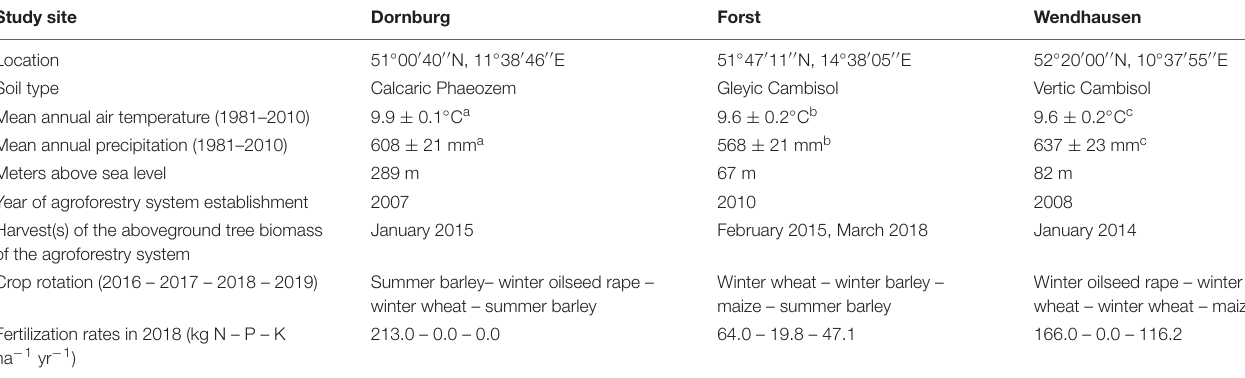
TABLE 1 | Site characteristics and management at the three study sites of paired temperate agroforestry and monoculture cropland. Study